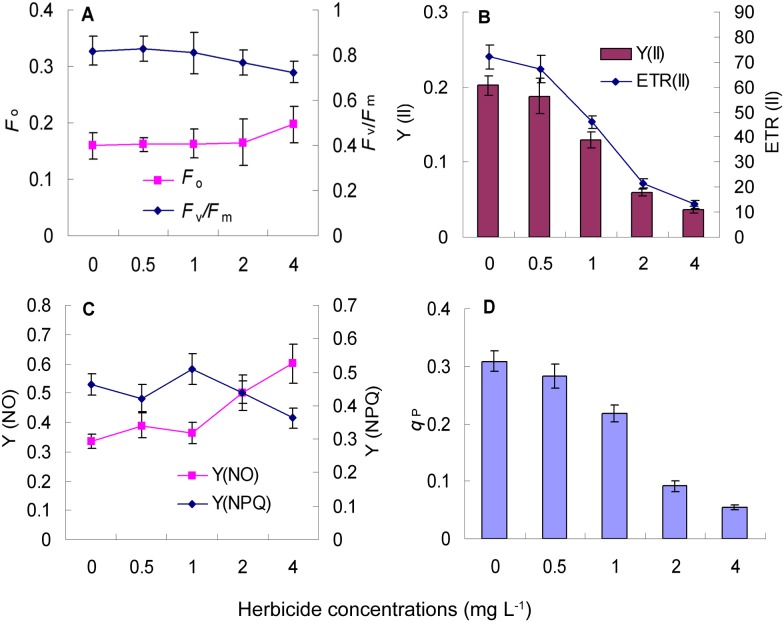
Effect of nicosulfuron on chlorophyll fluorescence parameters in leaves of Radix Isatidis seedlings.Values represent the means and vertical bars indicate the standard deviation of three separate experiments. F
o, F
v/F
m, Y(II), ETR (II), Y(NO), Y(NPQ) and q
P represent initial fluorescence, PS II maximum quantum yield, PS II electron transport rate, PS II effective quantum yield, quantum yield of non-regulated energy dissipation in PS II, quantum yield of regulated energy dissipation in PS II, and photochemical quenching, respectively. The abscissa in the figure represents the concentration of nicosulfuron and the unit is “mg L−1”.